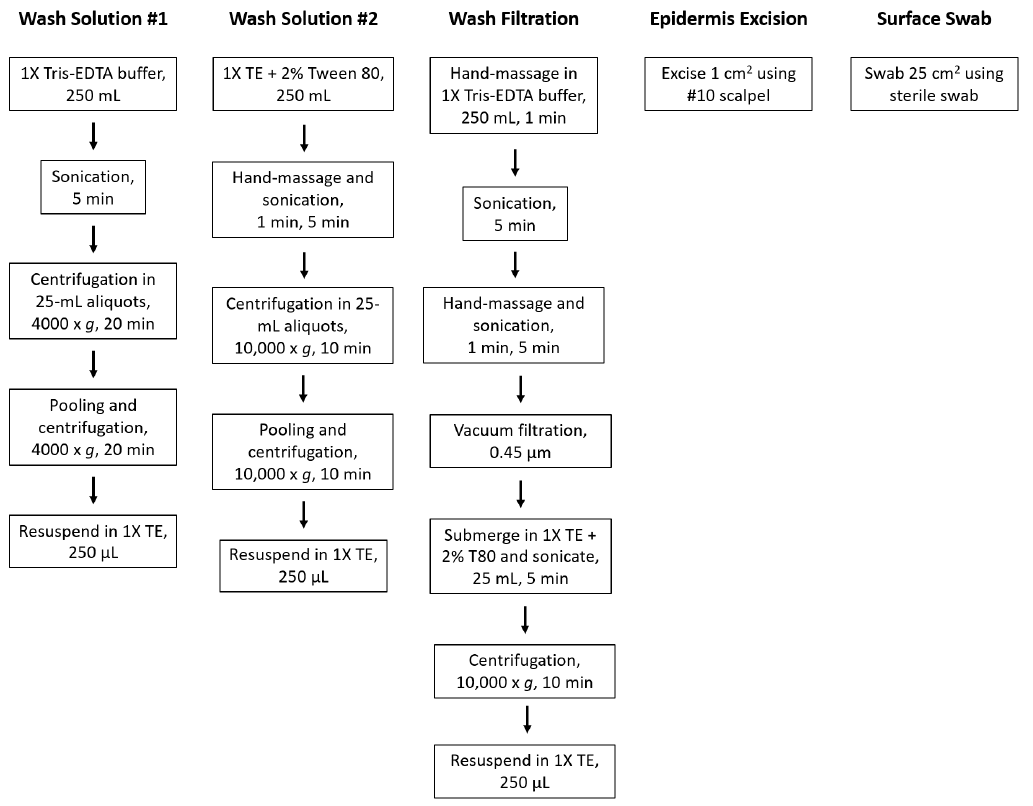
Figure 1. Simplified laboratory activities used for sample preparation. Activities described followed by DNA extraction and quantification.